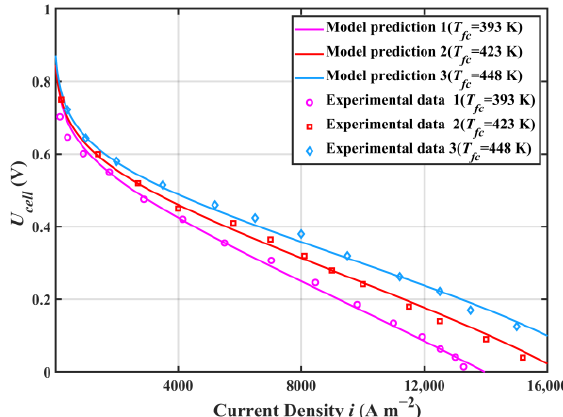
Figure 1. HT-PEMFC single cell voltage model validation (Inlet pressure 𝑝 = 1 atm; The relative humidity of the reaction gas 𝑅𝐻 = 0.38% ).